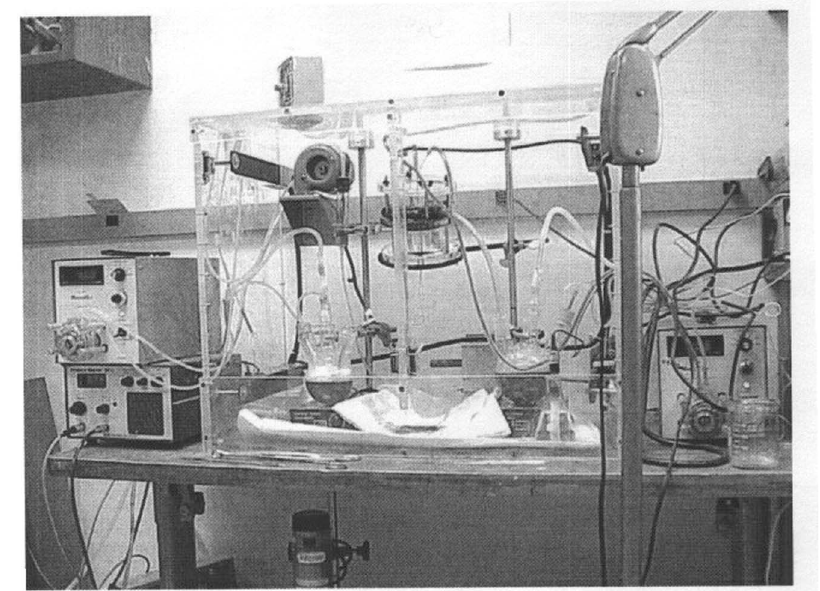
Figure 2. Placental perfusion model.